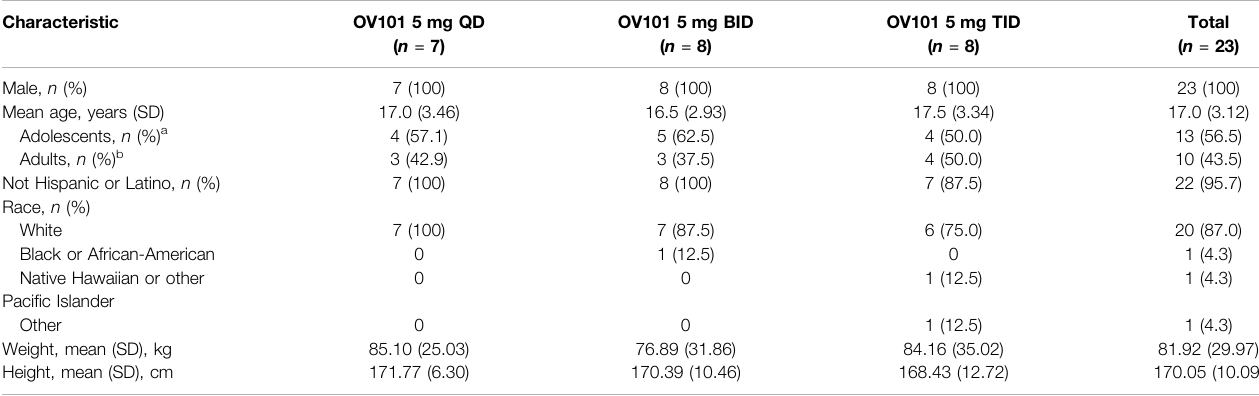
TABLE 1 | Baseline demographic